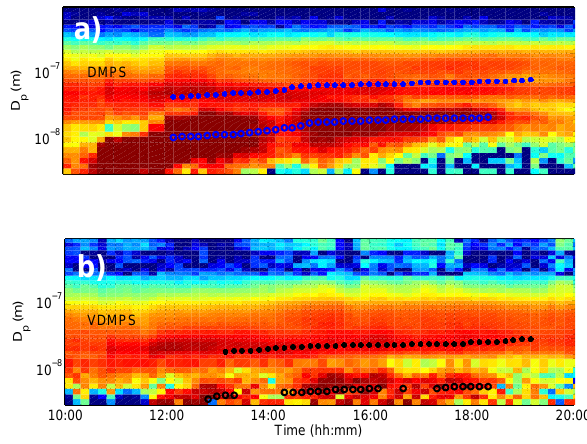
Fig. 2. Timeseries of the aerosol size distribution with time mea- sured by the (a) DMPS and (b) VDMPS on 10 April 2007 in Hyyti¨al¨a. Aerosols in VDMPS were heated to 280 ◦ C for 1 s be- fore measurement. The blue and black markers denote the geomet- ric number-mean diameters of the Aitken and nucleation modes for each size scan. These number-mean diameters are averaged over the time of the nucleation event and used as inputs to the C ∗ fit in the kinetic evaporation